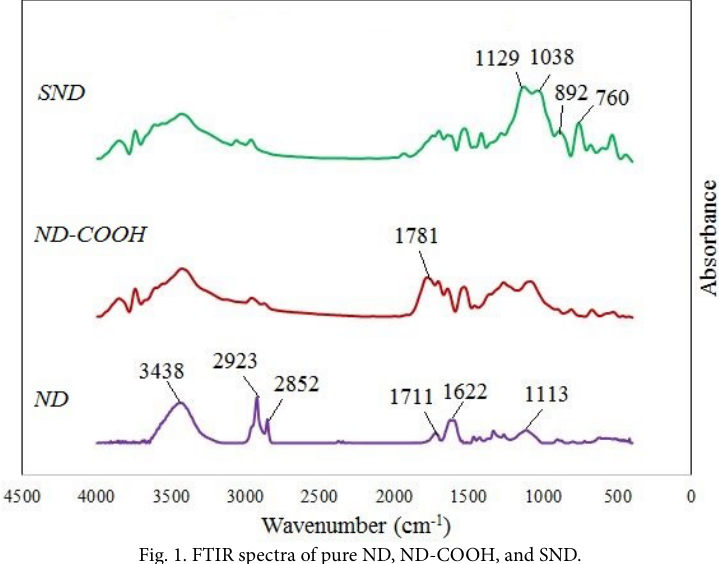
Fig. 1. FTIR spectra of pure ND, ND-COOH, and SND. Table 2. Contact angle, porosity, water content and PWF results for neat and nanocomposite PSf membranes. Table 1. Casting solution composition of neat and nanocomposite PSf Contact angle, Membrane degree